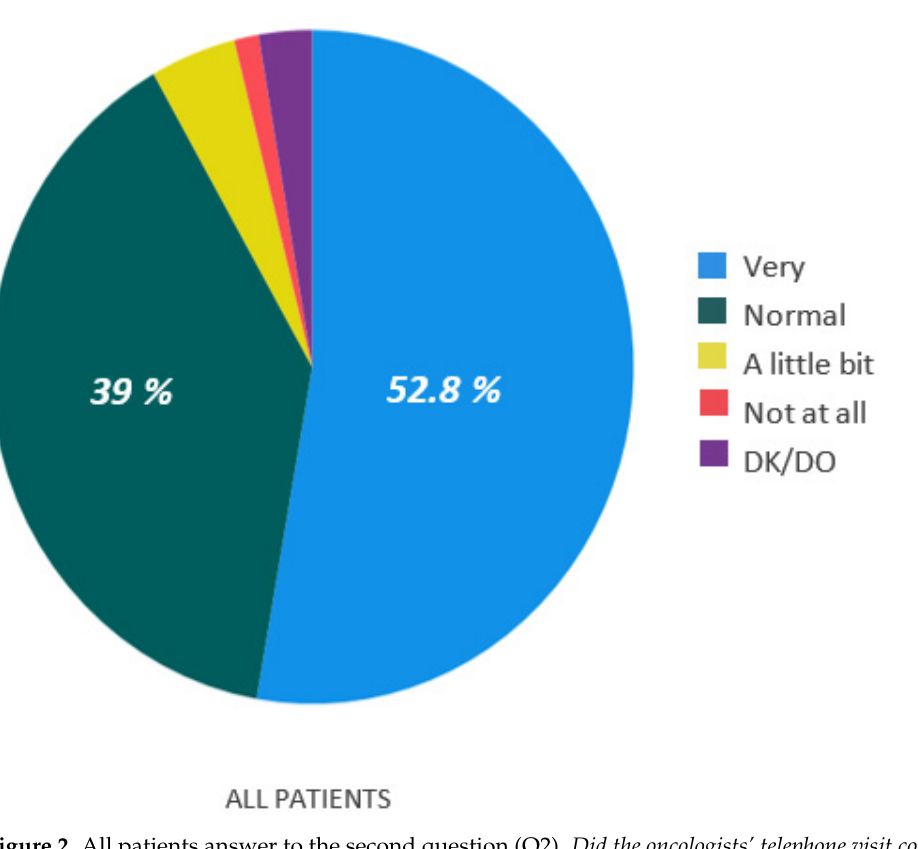
Figure 2. All patients answer to the second question (Q2). Did the oncologists’ telephone visit comfort you regarding your disease and its